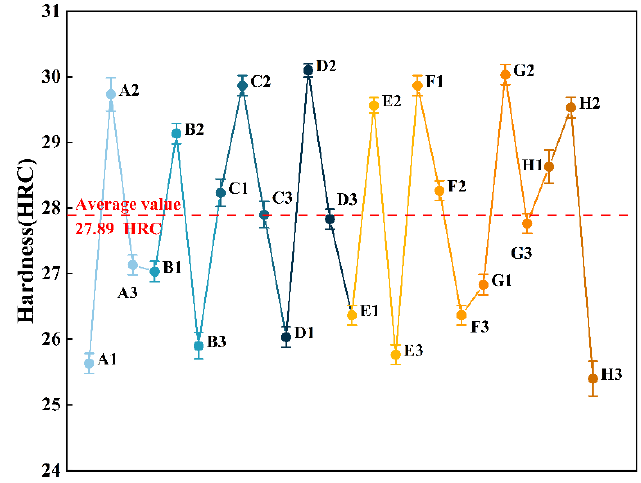
Figure 3. Hardness measurement point in A-H direction.